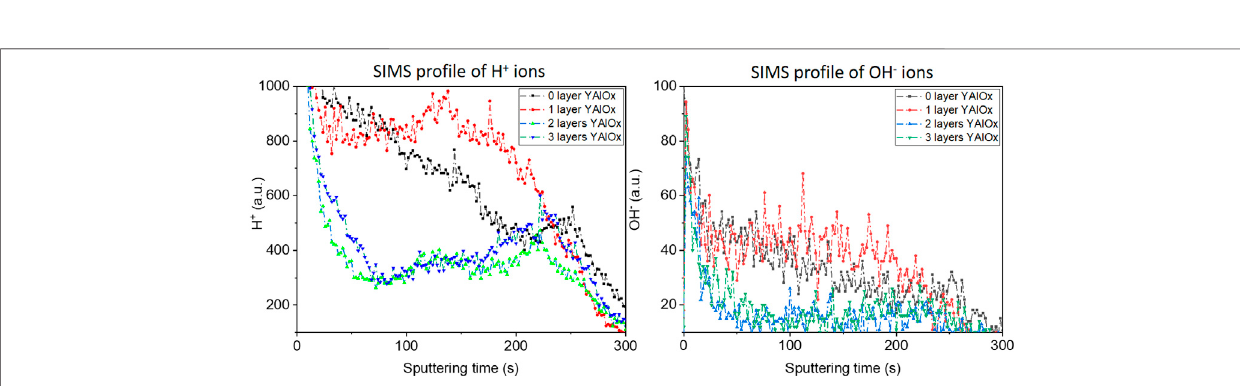
Frontiers in Electronics |